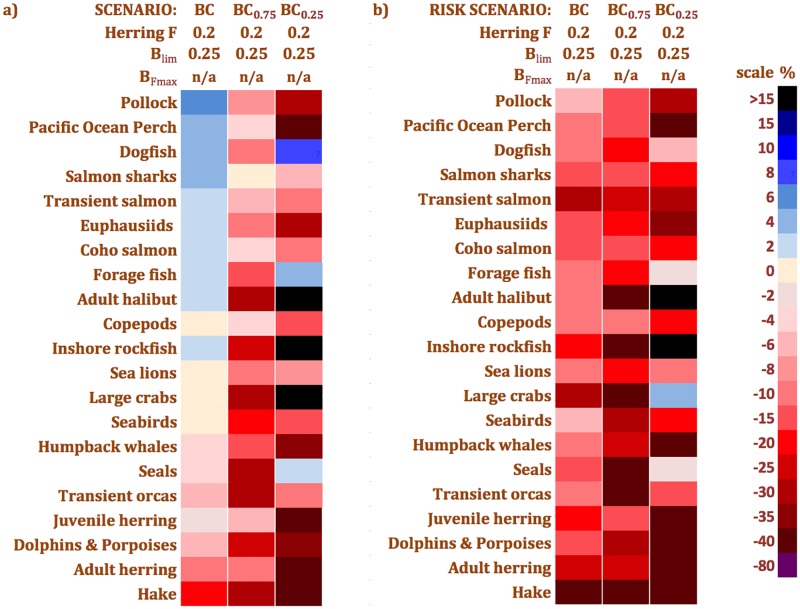
a) grand mean and b) grand mean minus 0.675 standard deviations (μ—0.675σ) group biomass changes for BC climate EwE MSE scenarios. BC0.75 simulates “no good productivity years” while BC0.25 represents “only bad years”.